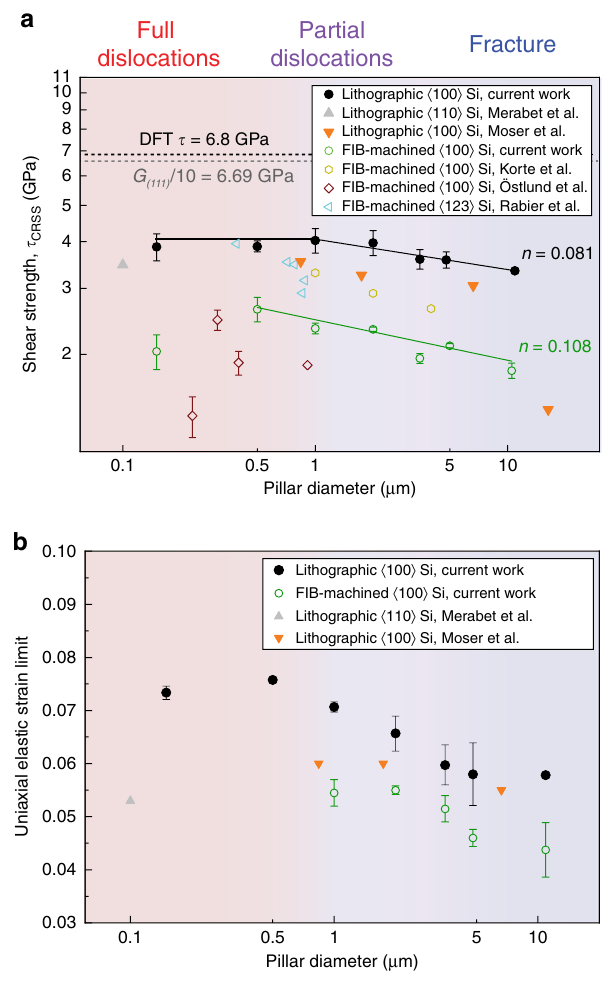
Fig. 4 Mechanical properties of lithographic and FIB-machined Si micropillars from microcompression at room temperature. a Critical resolved shear stress (CRSS) as a function of pillar diameter with comparison to literature values 11,20,23,28,31,32 . The upper limit of ideal strength is calculated from density function theory (DFT). b Elastic strain limit as a function of pillar diameter under microcompression 11,20 . The error bars are two standard